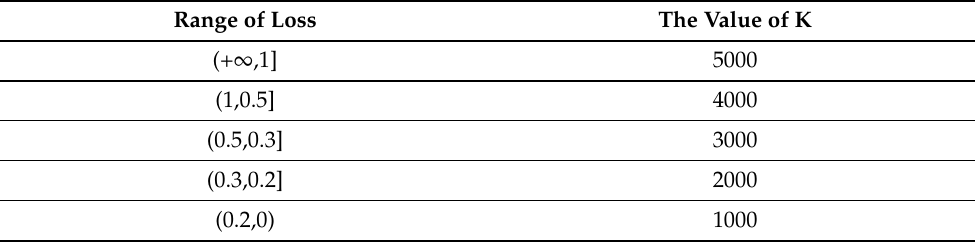
Table 2. K values and their corresponding ranges of loss